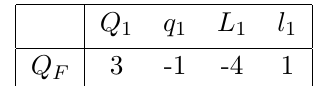
Table 3 . U(1) F family symmetry charges for the (cid:12)rst